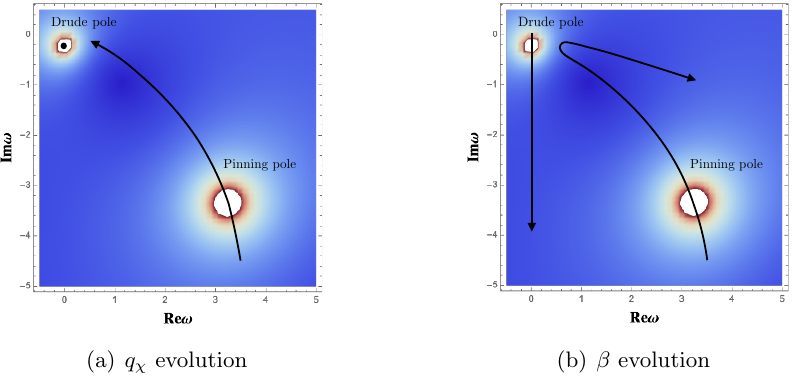
Figure 8 . (a) q (cid:31) evolution of the Drude and the pinning pole. (b) (cid:12) evolution of the Drude and the pinning pole. The density plot is drawn with (cid:22)=T = 5, (cid:12)=T = 2, q (cid:31) = 5 and H = 0.